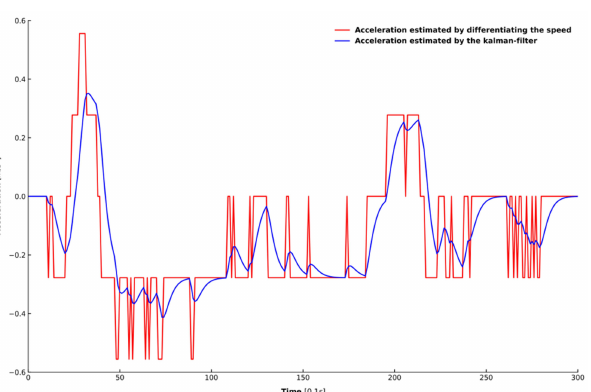
Figure 6. The speed in one car-following period.